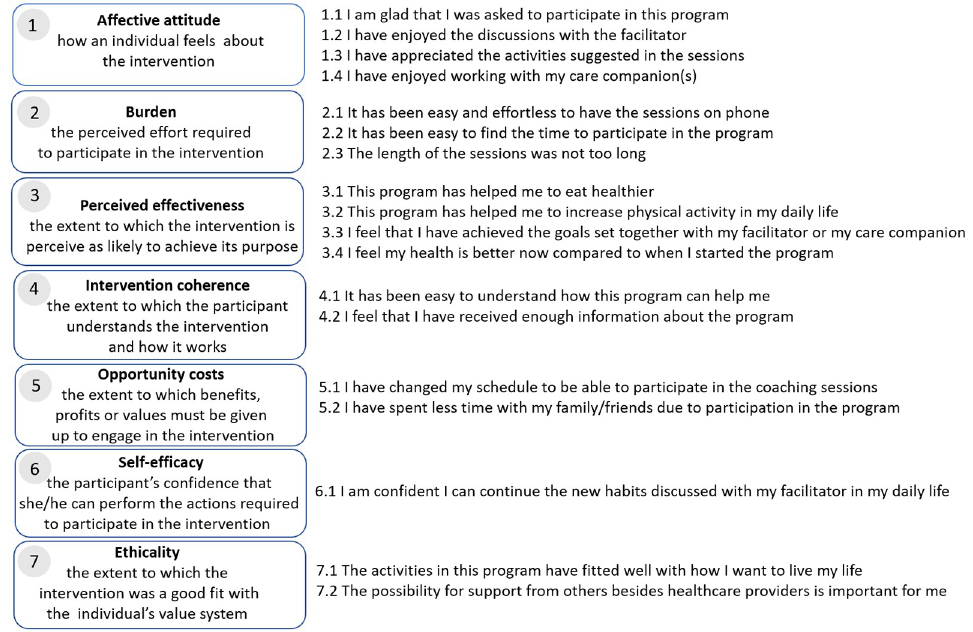
Fig 1. Questions related to the seven domains in Sekhon’s Theoretical Framework of Acceptability.